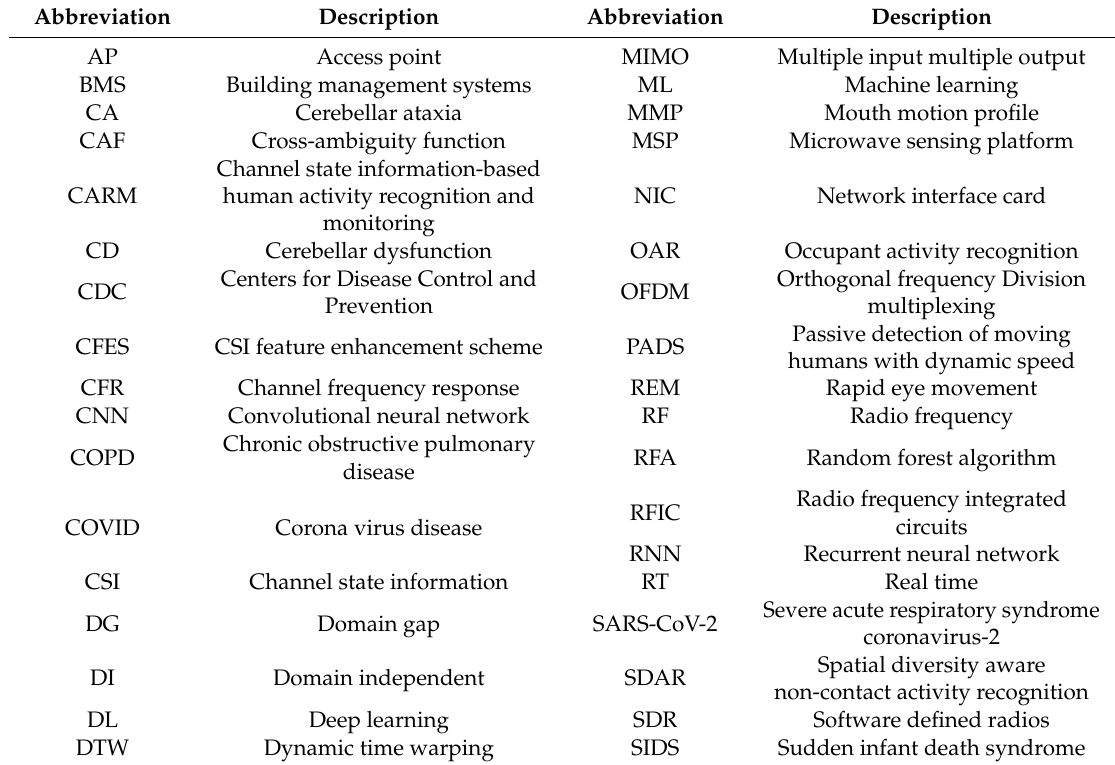
Table 1. List of abbreviations